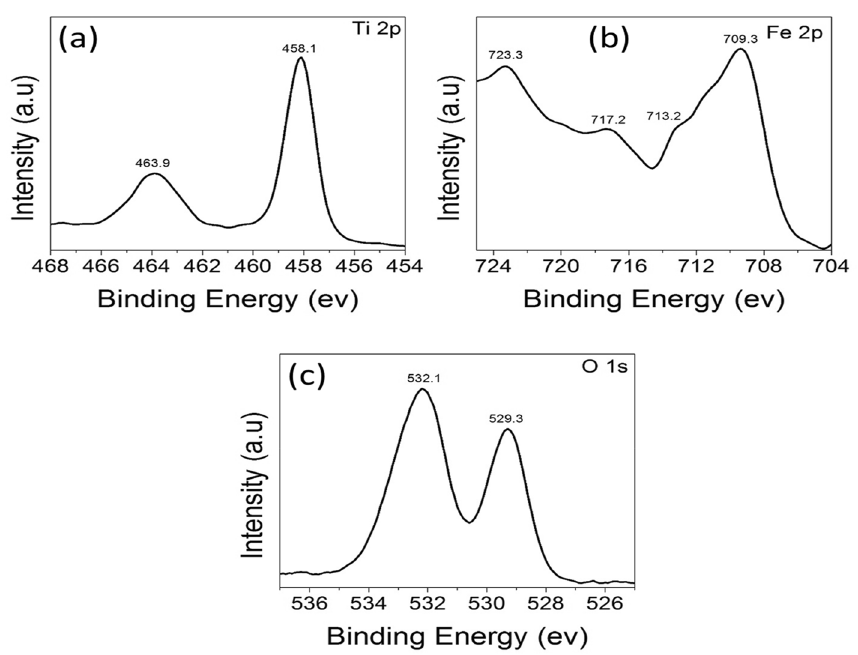
Figure 9. High-Resolution XPS spectra of ( a ) Ti 2p, ( b ) Fe 2p, and ( c ) O1s of 4% wt n-TiO 2 @α-Fe 2 O 3